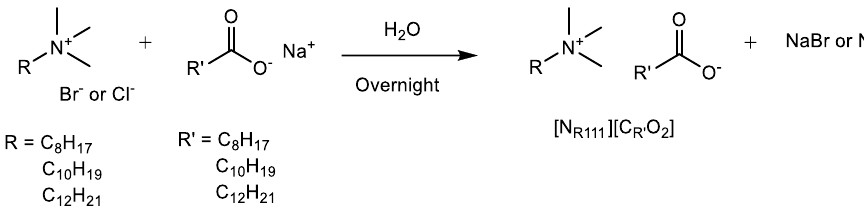
Table 1. Surface tension ( 𝛾 𝑙 ) and corresponding polar ( 𝛾 𝑙𝑝 ) and dispersive ( 𝛾 𝑙𝑑 ) components of the standard liquids used for surface energy calculations [18,19].